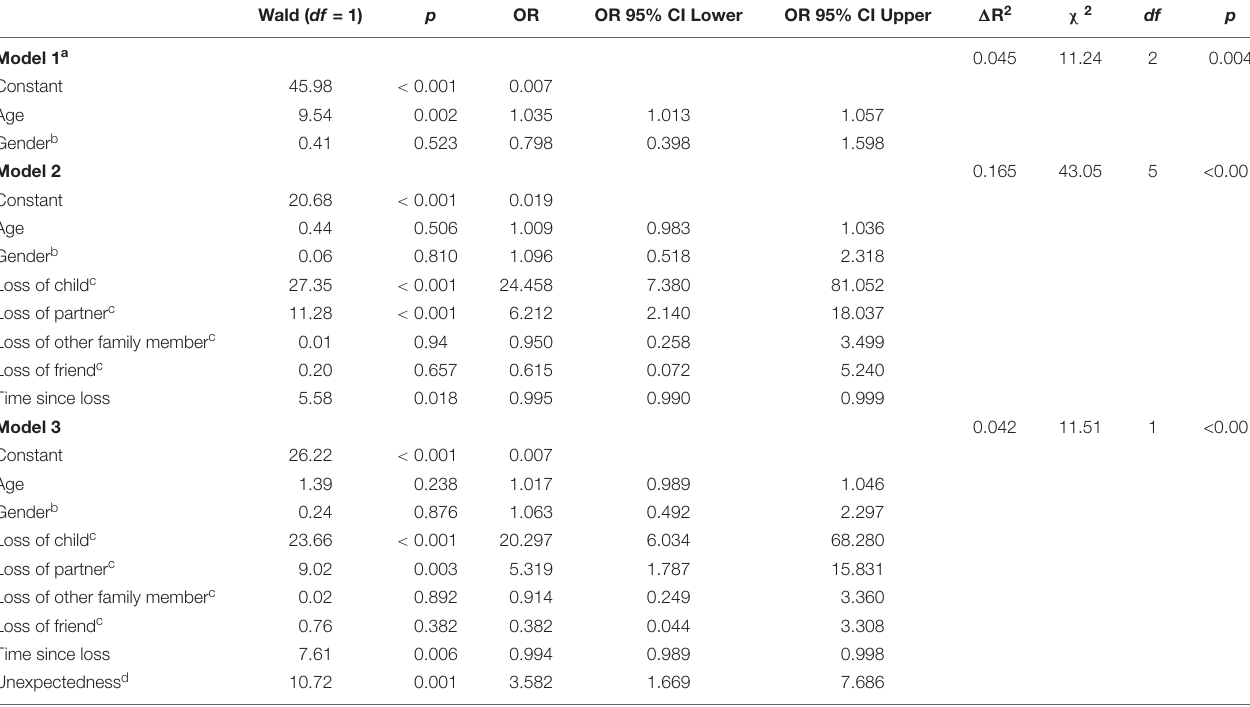
TABLE 2 | Blockwise hierarchical binary logistic regression with the criterion candidate for PGD caseness (PGD case/no PGD case). Wald ( df =